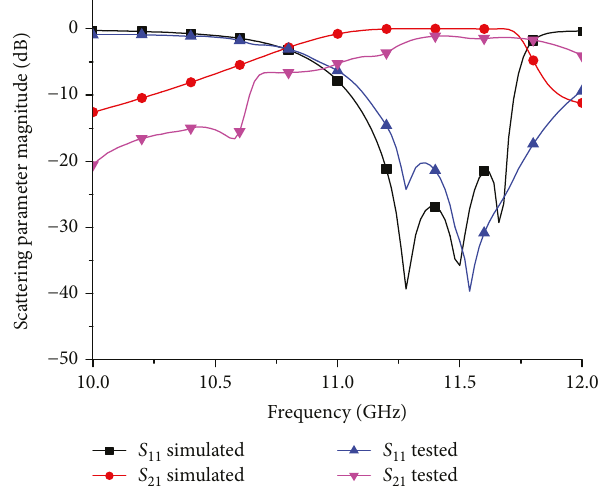
Figure 9: Simulated and tested scattering parameter